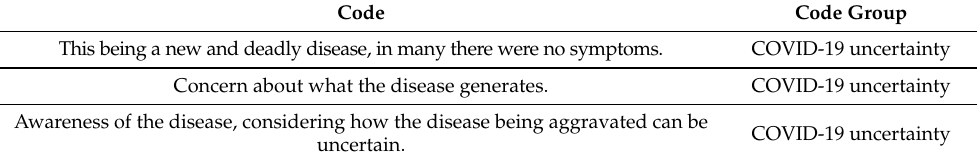
Table 9. Code group: COVID-19 uncertainty.